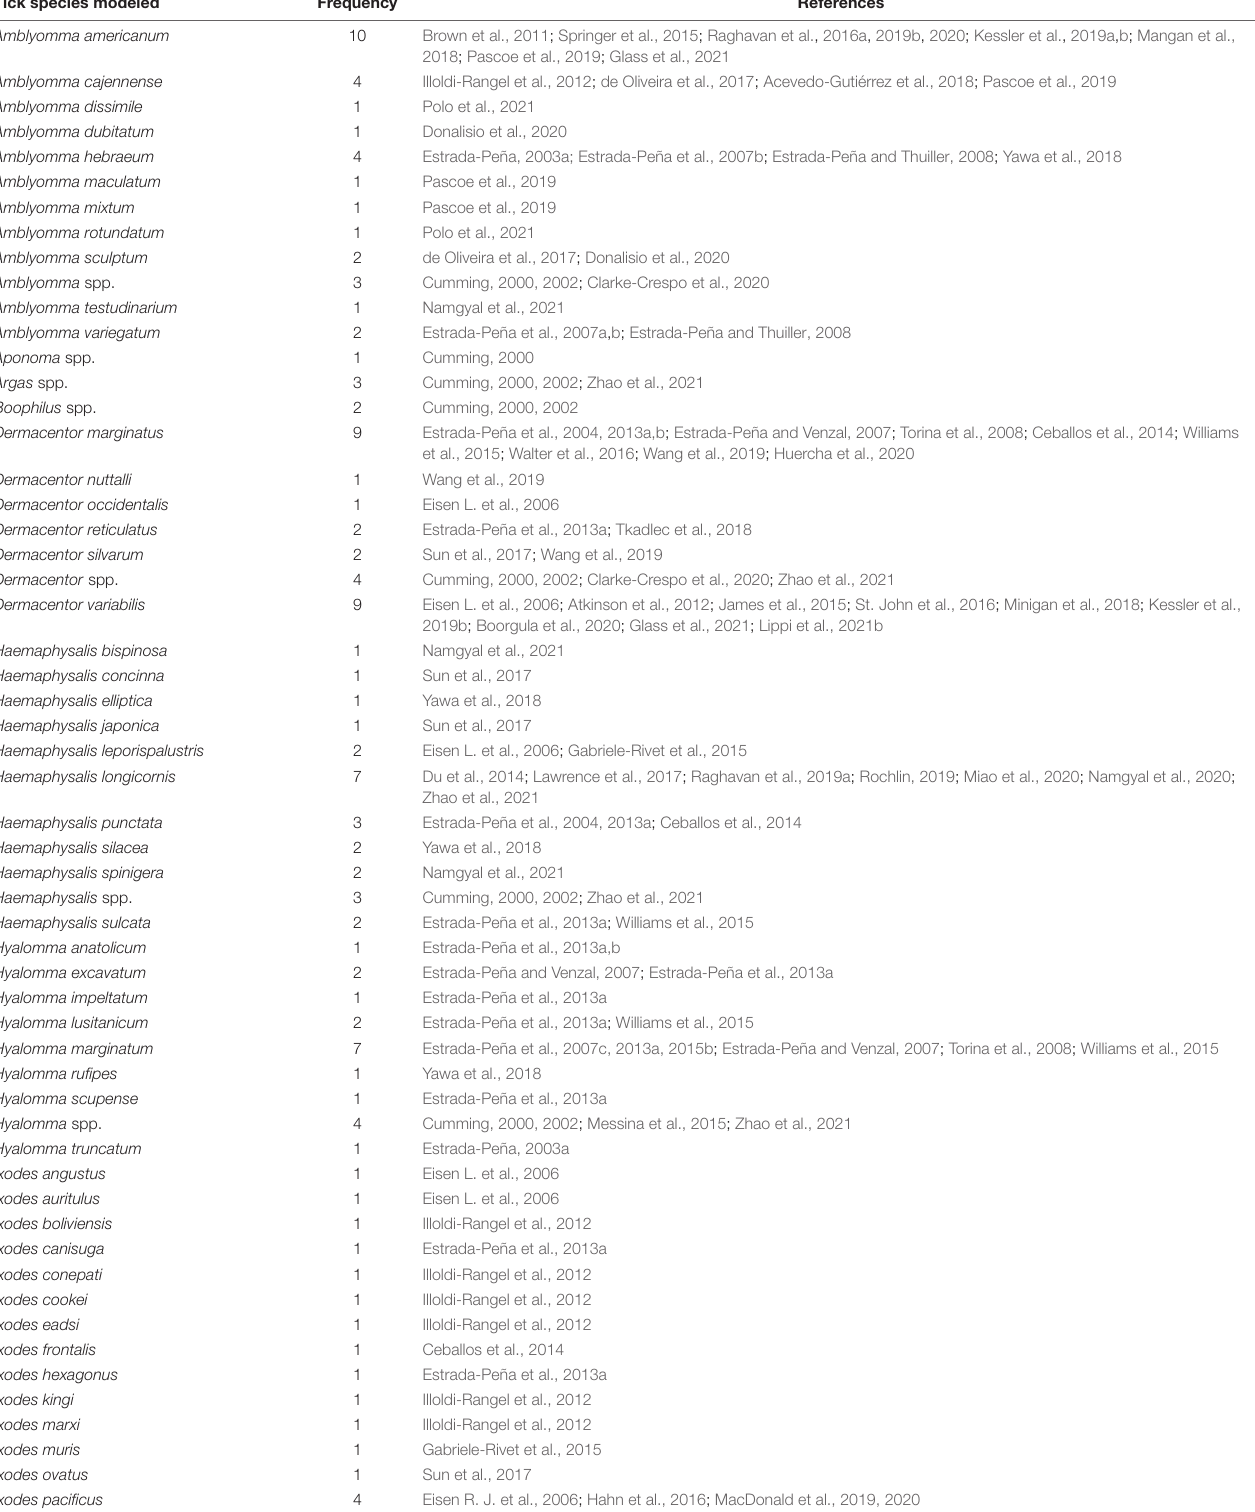
TABLE 1 | Summary of tick species ( n = 95) modeled across all included literature ( n = 107), and frequency of each species’ appearance. Tick species